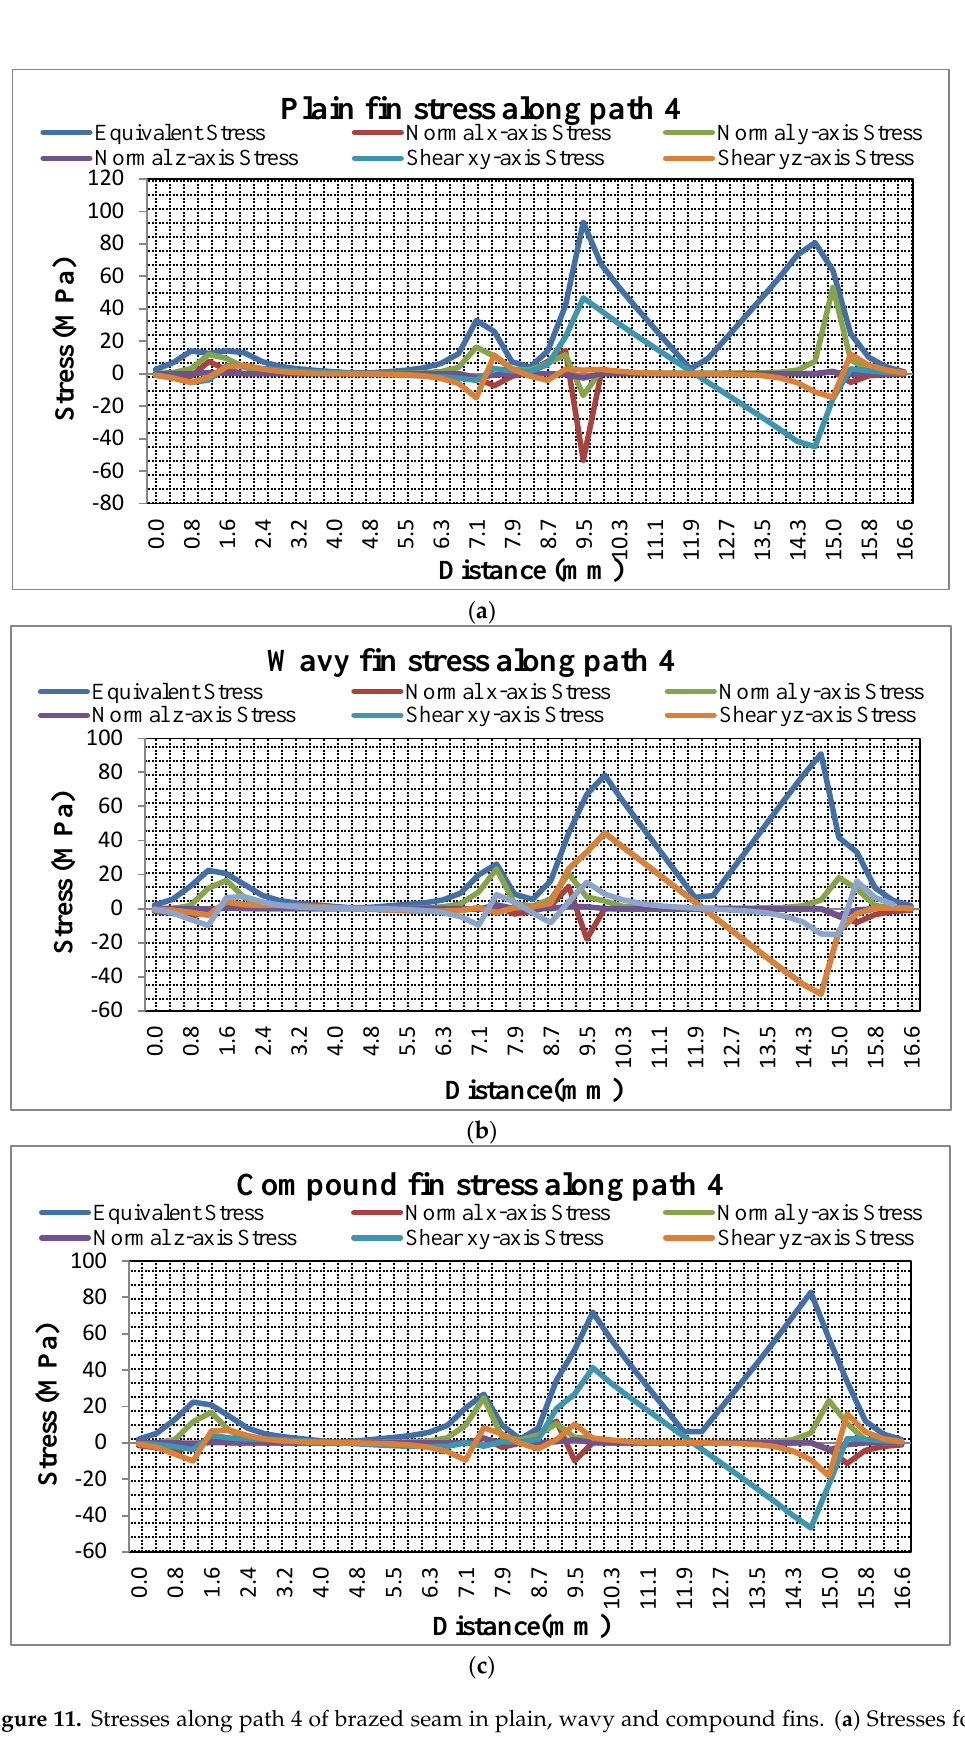
Figure 11. Stresses along path 4 of brazed seam in plain, wavy and compound fins. ( a ) Stresses for plain fin. ( b ) Stresses for wavy fin. ( c ) Stresses for compound fin.